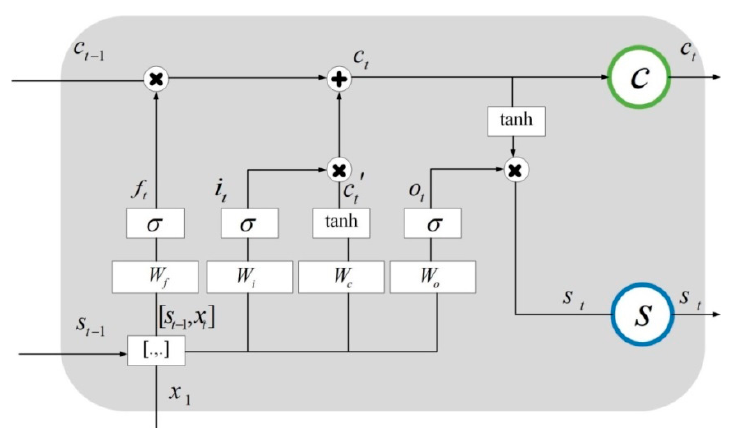
Figure 4. Three gates of the LSTM network.